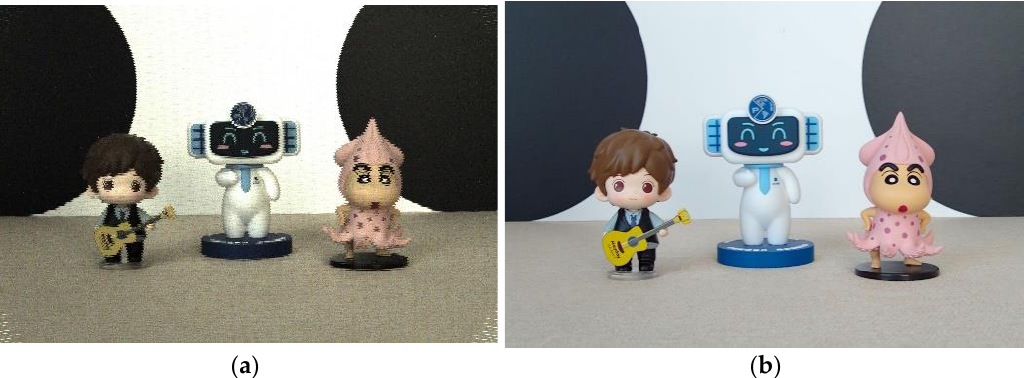
Figure 5. Scene 4 light field full-focus image. ( a ) The original images of the light field. ( b ) The full-focus images of the light field.